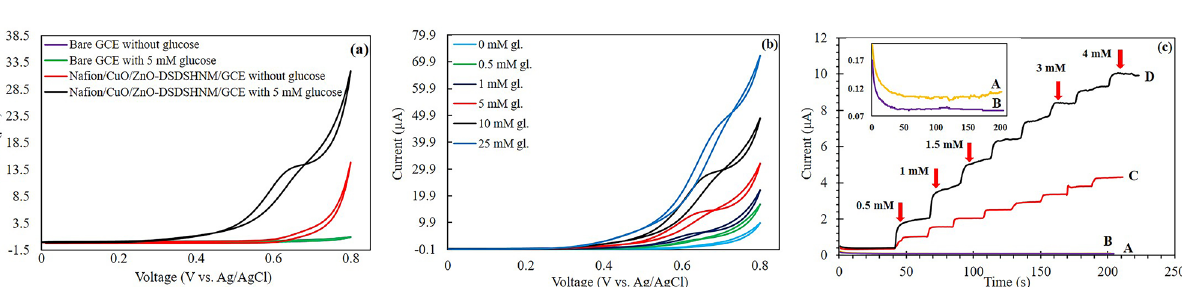
Figure 6. ( a ) The CV responses of the bare and the modified GCE with CuO/ZnO-DSDSHNM at the scan rate of 50 mVs −1 in the absence and presence of 5 mM glucose. ( b )The CVs of Nafion/CuO/ZnO-DSDSHNM/ GCE at the scan rate of 50 mVfs −1 in 0.5 M NaOH solution at different glucose concentrations. ( c ) i–t curves of ( A ) bare GCE, ( B ) Nafion/ZnO-MS/GCE, ( C ) Nafion/CuO-MS/GCE, and ( D ) Nafion/CuO/ZnO-DSDSHNM/ GCE by successive addition of 0.50 mM of glucose to the final concentration of 4 mM. The inset plot of ( c ) is the magnified view of the ( A ) bare GCE and ( B ) Nafion/ZnO-MS/GCE by successive addition glucose in the range of 0.50–4